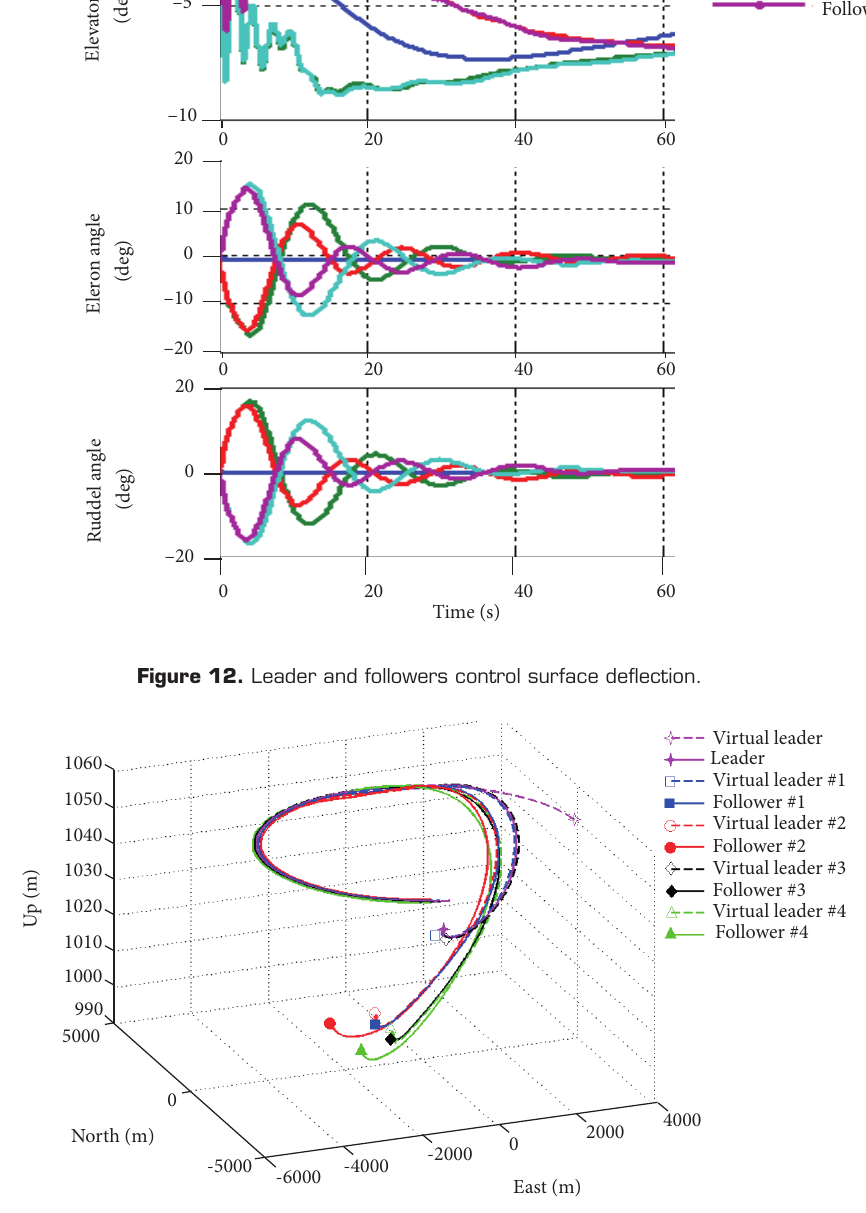
Figure 13. Steady state level